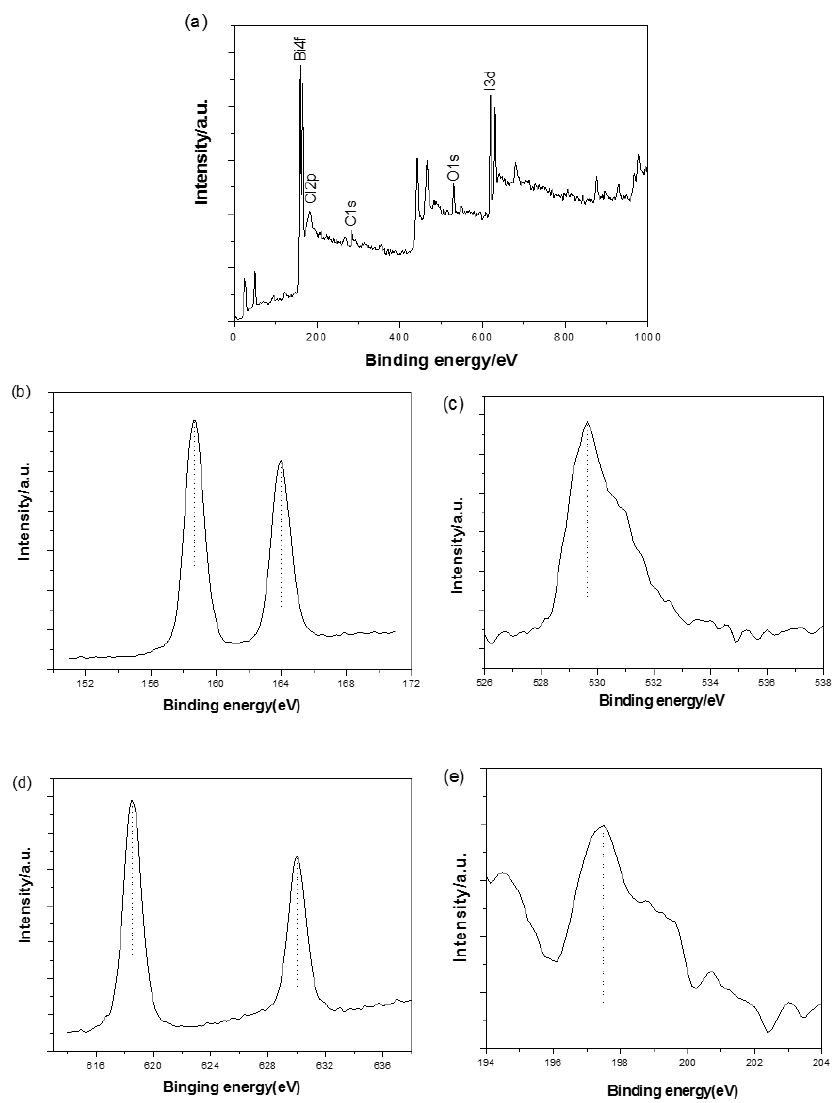
Figure 5. ( a ) X-ray photoelectron spectroscopy (XPS) spectra survey and high-resolution scan of ( b ) Bi 4f; ( c ) O 1s; ( d ) I 3d and ( e ) Cl 2p of BiOI/BiOCl composite. Table 1. Surface chemical composition and concentration of the BiOI/BiOCl catalyst.